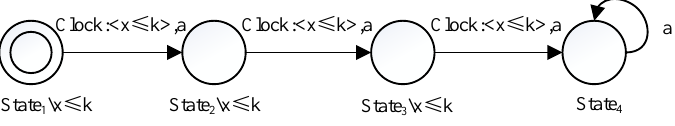
Figure 7. Property pattern of Occurrence